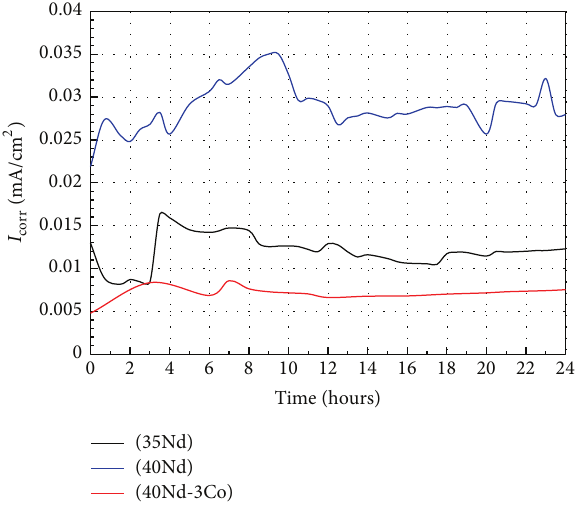
Figure 5: Variation of 𝐼 corr values for Nd magnets tested in 3.5% NaCl solution at 25 ∘ C for 24 hours.